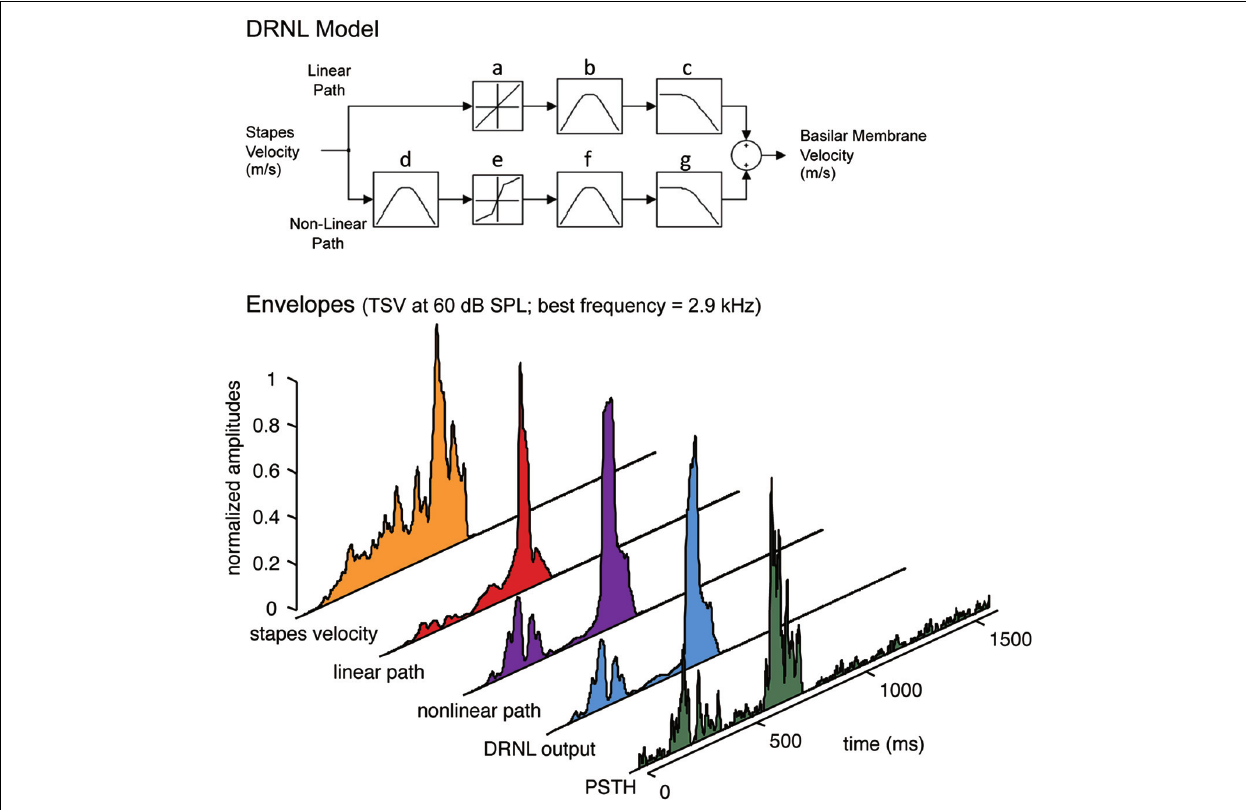
FIGURE 2 | Peripheral ear modeling and data processing. Top :The dual resonance non-linear (DRNL) model is fit with guinea pig parameters.The model simulates the peripheral processing from the stapes input to the output of a specified best frequency location along the basilar membrane.The model consists of a linear and a non-linear path, each with a set of gammatone bandpass filters (b, d, f) and Butterworth lowpass filters (c, g) that vary depending on the specified best frequency. In addition, the non-linear path of the model contains a broken stick compression function (e; also varying with best frequency and in contrast to the linear function in a) to estimate the non-linear effects of the cochlea. Bottom :The signals are extracted for each part of the DRNL model and compared with the neural response for a single ICC site. Before applying the DRNL model, the signal is first inputted through a middle ear filter (two Butterworth bandpass filters from 4 to 25 kHz and